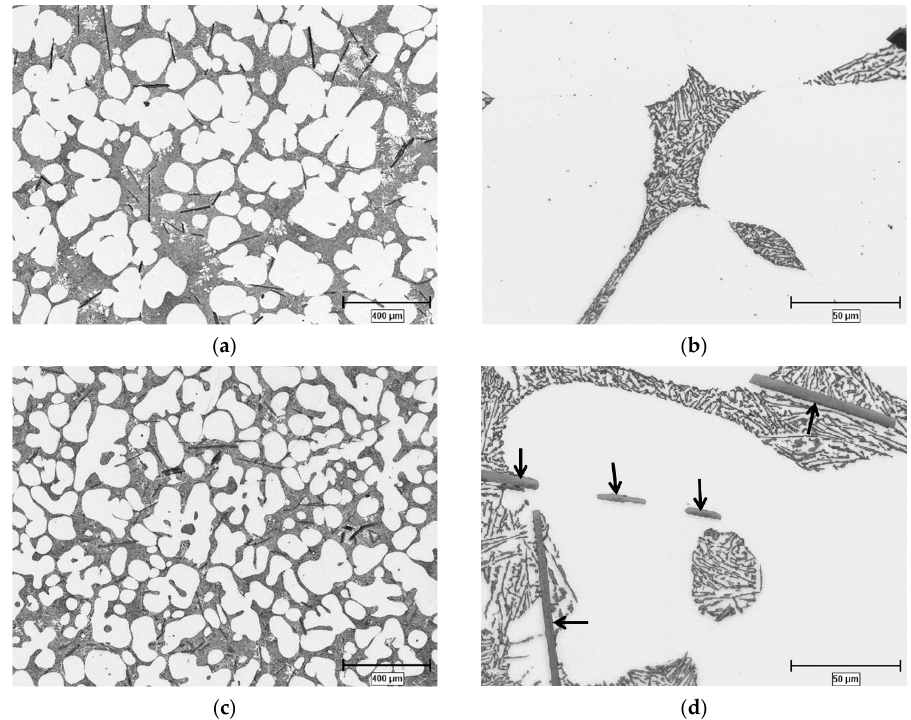
Figure 3. Optical micrographs showing the effect of isothermal holding on the microstructure of thixocast samples: ( a , b ) sand mold and ( c , d ) copper mold, pouring temperature 690 °C, etched with 0.5% HF (arrows show some of the iron-intermetallics). Scale bar is 400 μ m for ( a ) and ( c ), 50 μ m for ( b ) and ( d ).